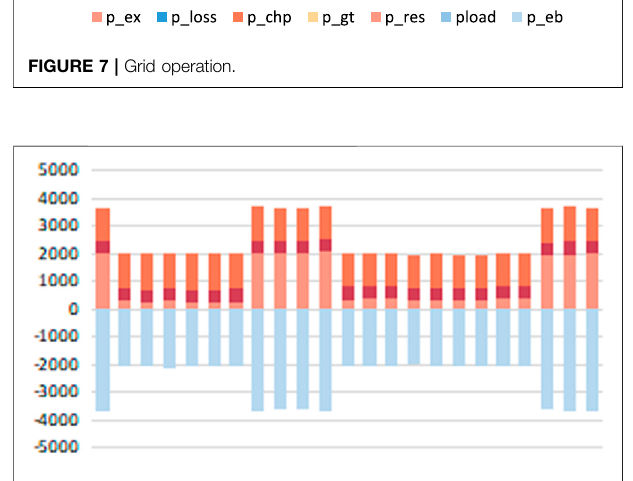
FIGURE 7 | Grid operation.